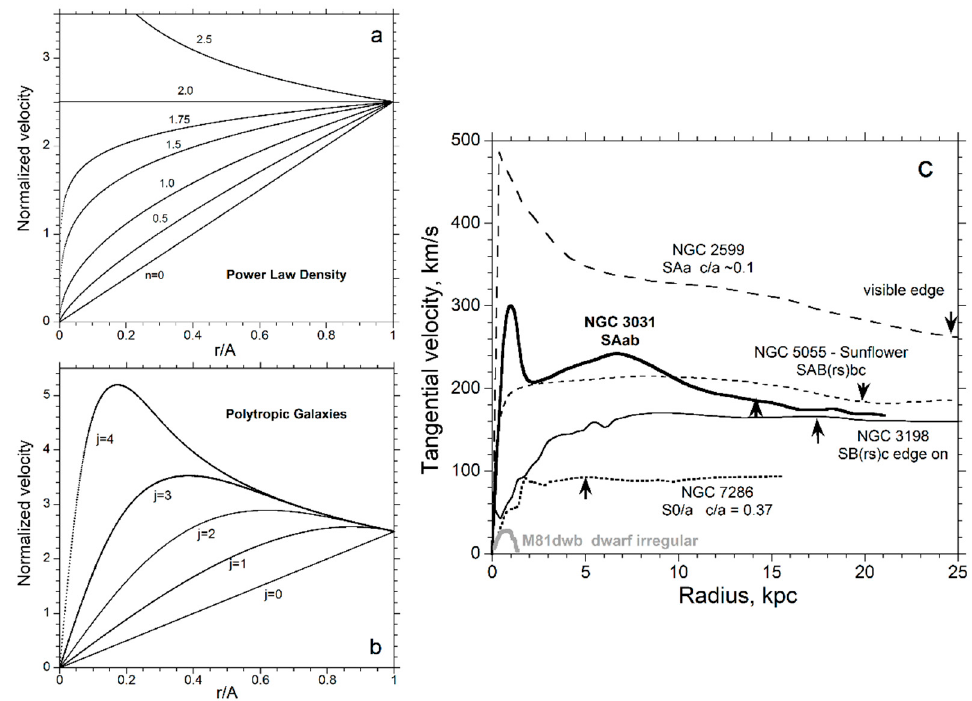
Figure 1. Forward models of galactic rotation curves presuming ( a ) a power law density distribution for various powers (Equation (15)), and ( b ) a polytropic density profile of indicated index, using the tabulated density coefficients of [38]. All bodies are presumed to have the same normalized mass of 4 π /3 at r = A , representing unit mean density. Vertical scale is for a spherical object; curves for any other spheroid will have identical shapes but the vertical scale will differ by a geometric factor. Please note that the n = 0 power law and the curve for polytropic index j = 0 both represent homogeneous density, in which case the angular velocity is constant throughout the object, requiring that tangential velocity increases linearly with radius. ( c ) Measured rotation curves for selected galaxies; the data source for M81dwb is [39]; NCG 2559 and 7286 data are from [40], whereas the remainder are from [41].